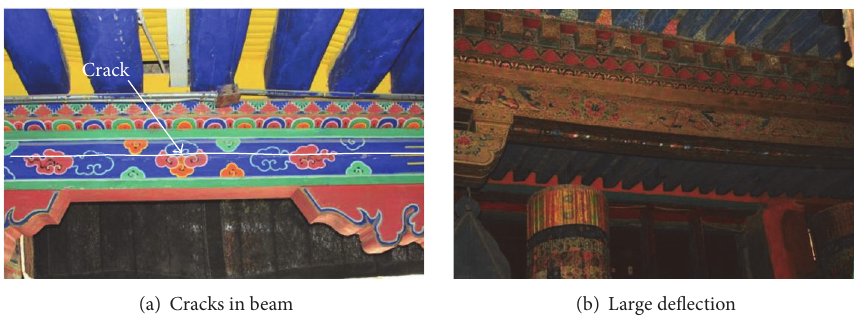
Figure 17: Damage of